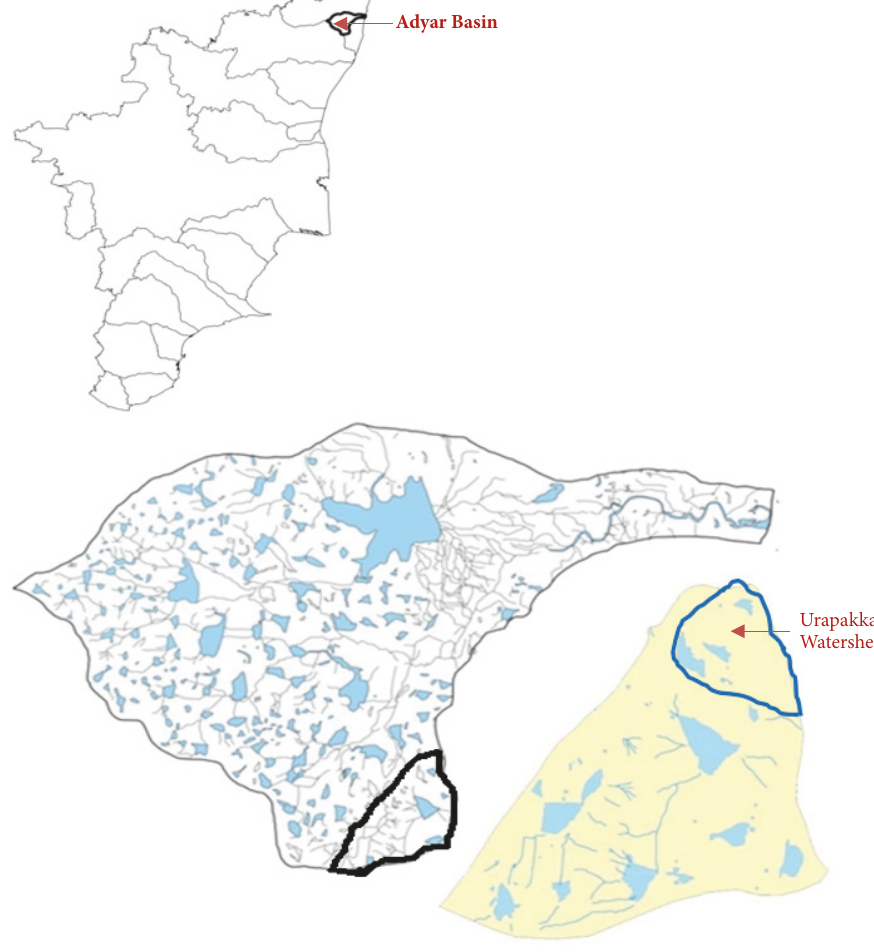
Figure 1: Index map of study